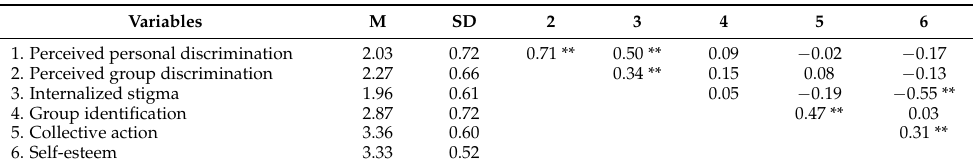
Table 2. Descriptive statistics and Pearson correlation coefficients for the sample of people with visual